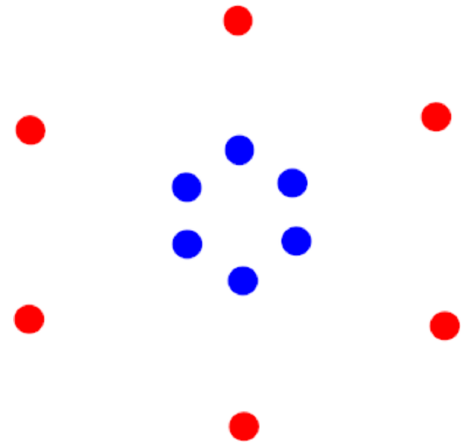
Figure 9 . By taking u 2 ,...,N − 1 = 0 and u N ≤ Λ N N mutually local exotic defects move into the interior region until they collide at the origin for u N = Λ N realizing the ( A 1 , A N − 1 ) AD